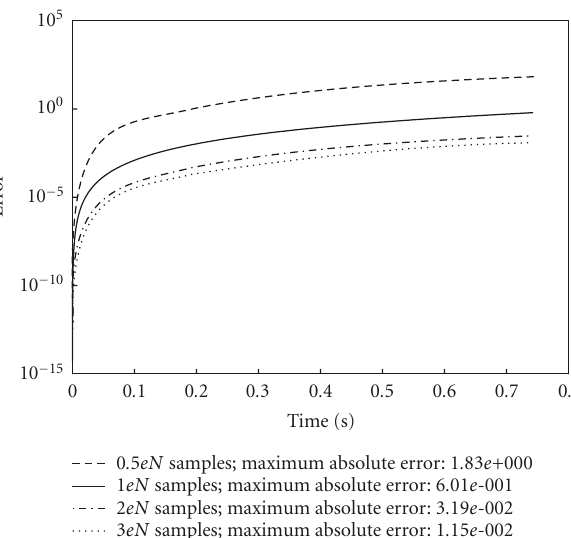
Figure 3: Reconstruction error for a white noise using twice as many samples as strictly needed (2 eN ).